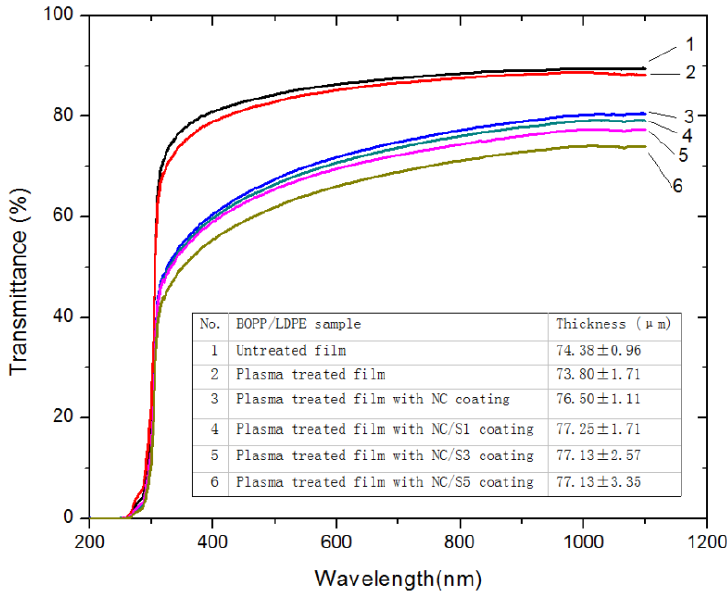
Figure 3. Light transmission of BOPP/LDPE films under different surface process.